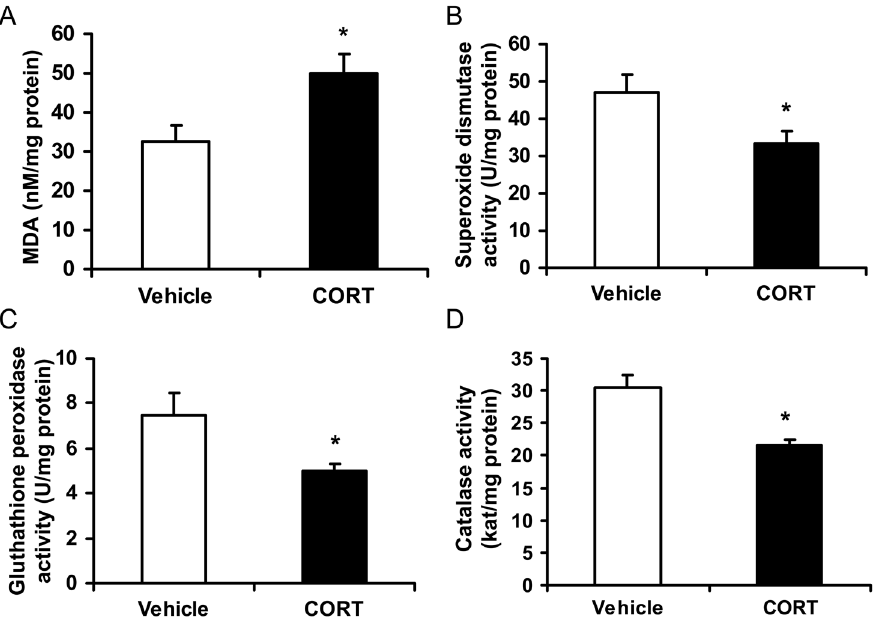
Figure 5. Effect of CORT on ROS defense system in epididymal WAT of mice. ( A ) Concentration of malondialdehyde (MDA), and activities of ( B ) superoxide dismutase, ( C ) gluthathione peroxidase, and ( D ) catalase in epididymal white adipose tissue (WAT) of mice treated with 100 m g/ml CORT or vehicle for 4 weeks. Data are expressed as group means 6 SEM (n=6 by group). * P , 0.05 compared with vehicle.